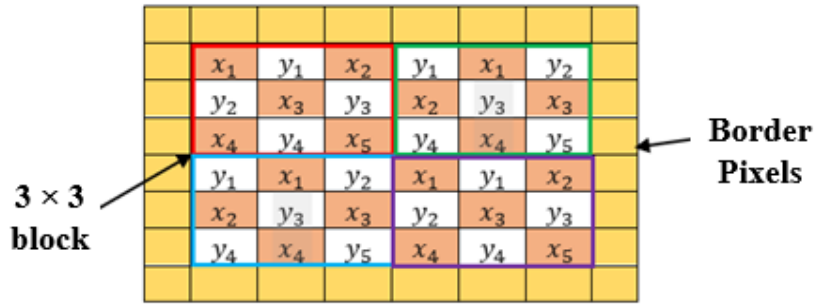
Figure 1. Checkboard representation of image.